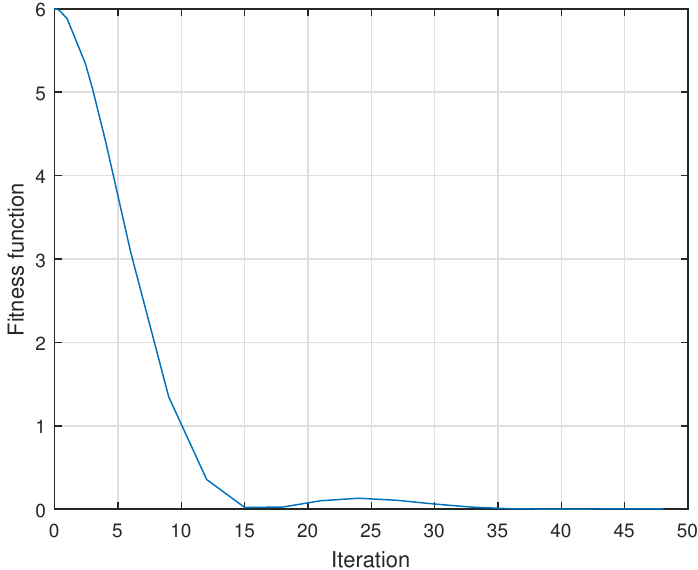
Figure 10. Reduction in the error in the iterations for the